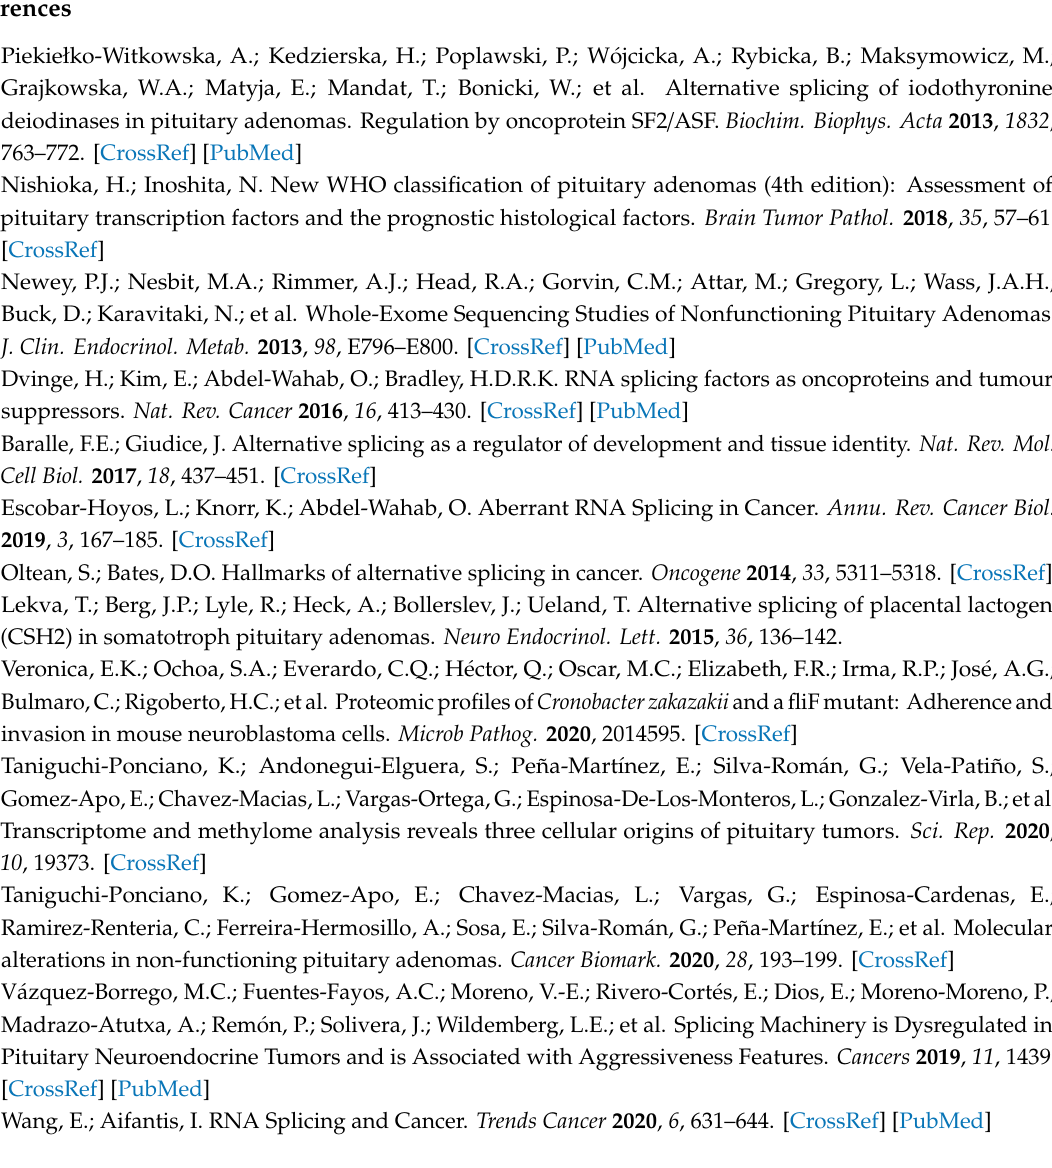
Figure S1: Pituitary hormones and transcription factor immunohistochemistry. Availability of Data and Materials: The data presented in this study are openly available in Gene Expression Omnibus (GEO), which is hosted by the National Center for Biotechnology Information (NCBI) at accession number